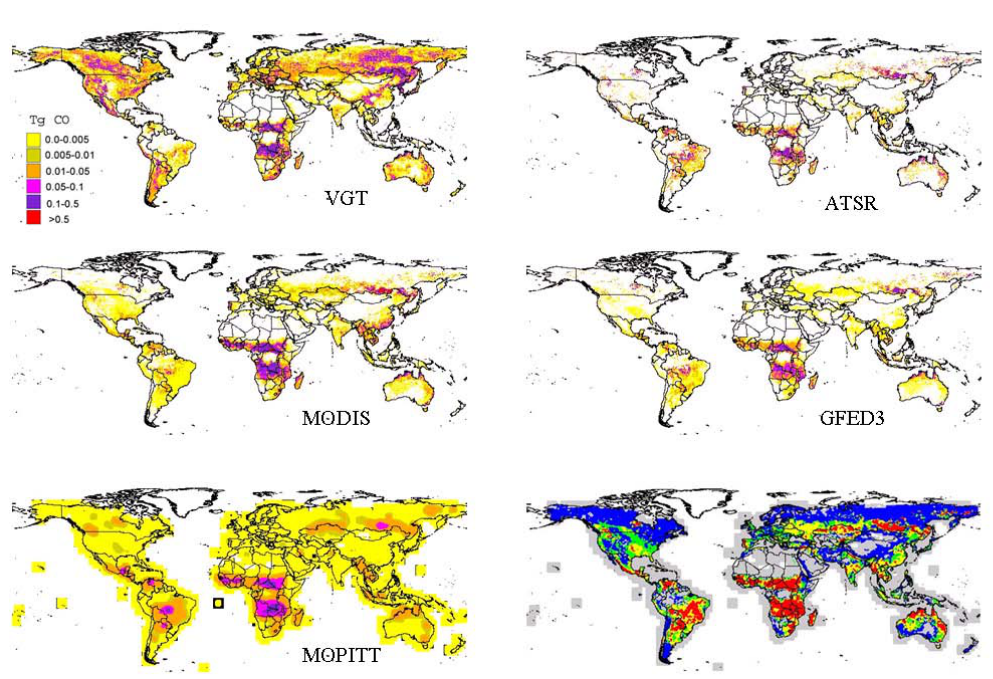
Fig. 1. Maps of CO emissions [Tg] for the year 2003 for 0.5 ◦ grid cells; in the right lower corner the map of agreement (i.e. the number of inventories for each cell with CO emissions greater than zero; grey = 1, blue = 2, green = 3, yellow = 4, red = 5). The agreement map has been filtered with a median filter (3 ×